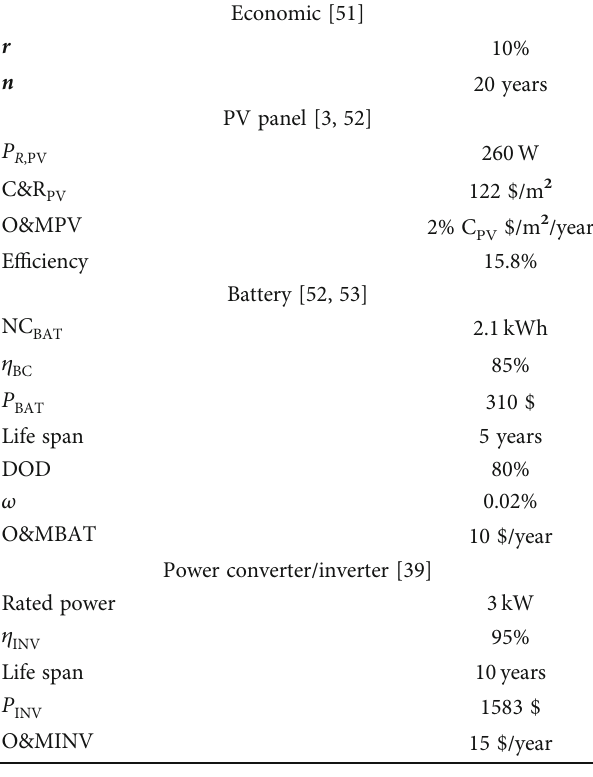
Table 1: Parameters of the hybrid system